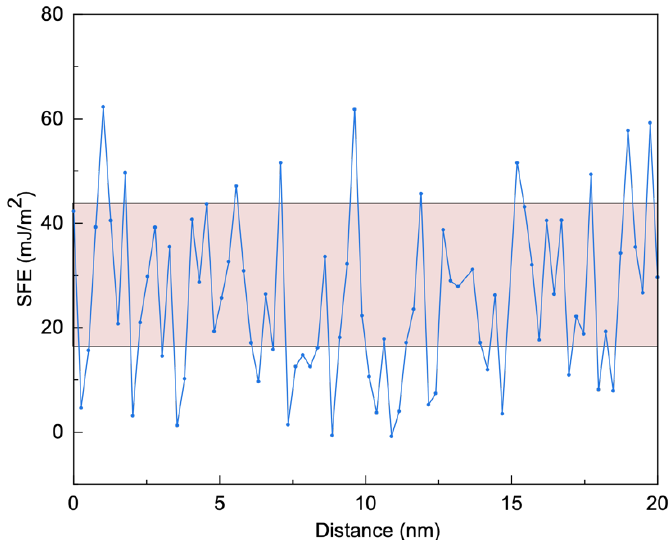
Figure 9. SFE profile calculated based on an empirical formula. The marked range of the SFE data from the reference [25,57].